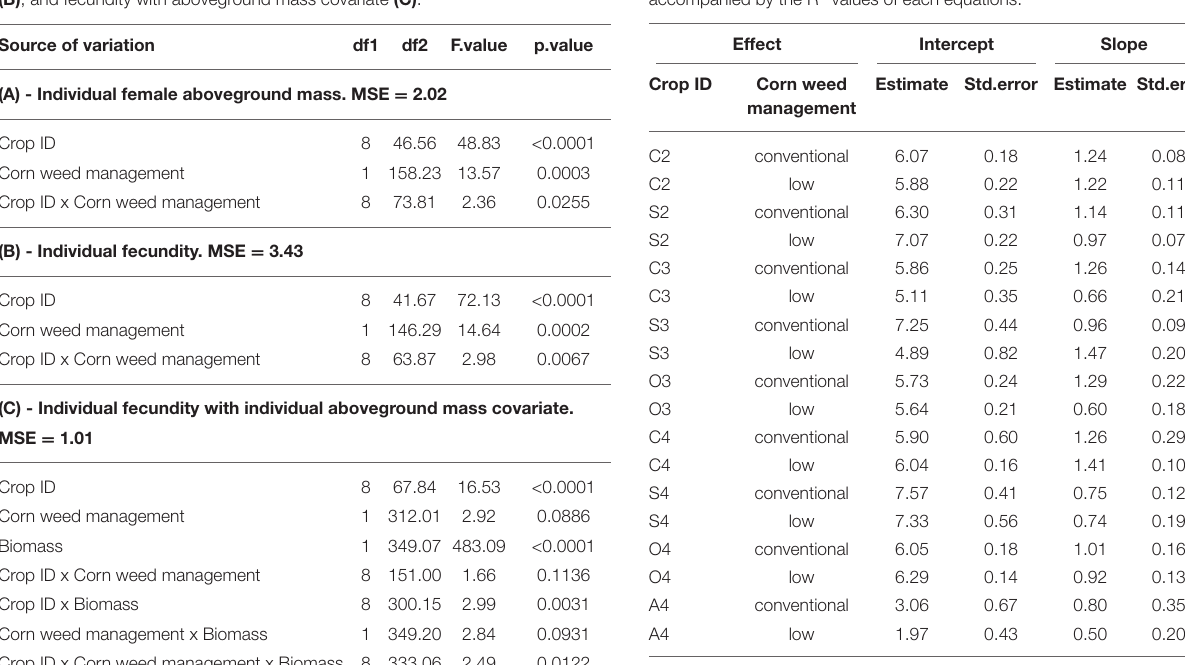
TABLE 9 | Means and SEs for estimated linear regression of waterhemp fecundity index [ln(seeds + 1)] vs. biomass index [ln(gram + 0.005)] intercepts and slopes, accompanied by the R 2 values of each